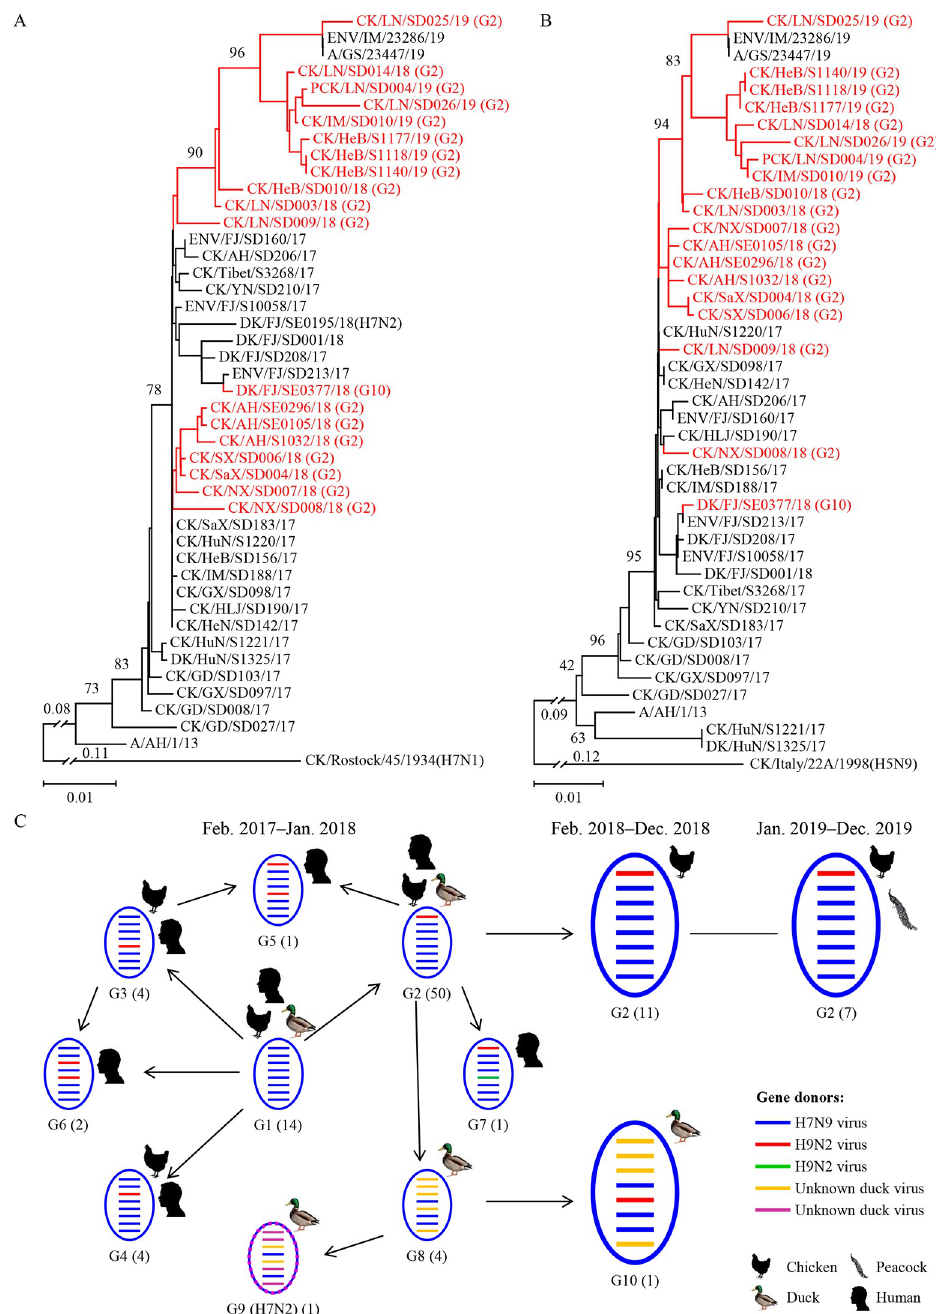
Fig 1. Phylogenetic analyses and genotypes of H7N9 highly pathogenic avian influenza viruses. The phylogenetic trees of the HA (A) and NA (B) genes were rooted to A/chicken/Rostock/45/1934 (H7N1) and A/chicken/Italy/22A/ 1998 (H5N9), respectively. The viruses sequenced in this study are shown in red in the phylogenetic trees. (C) Genotypes of H7N9 and H7N2 viruses and the hosts in which these genotypes were detected. The genotypes of the viruses isolated between February 2017 and January 2018 were reported previously [7]; the viruses isolated between February 2018 and December 2019 were analyzed in this study. The numbers of strains of each genotype are provided in